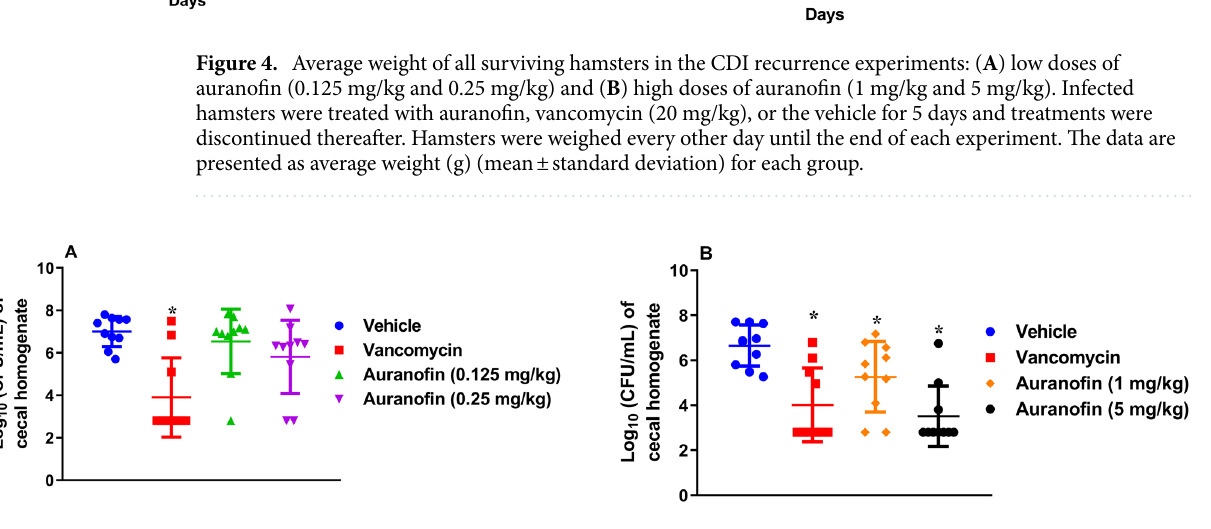
Figure 5. C. difficile UNT103-1 CFU counts in the cecal tissues of infected hamsters: ( A ) low doses of auranofin (0.125 mg/kg and 0.25 mg/kg) and ( B ) high doses of auranofin (1 mg/kg and 5 mg/kg). Infected hamsters were treated with auranofin, vancomycin (20 mg/kg), or the vehicle for 5 days and treatments were discontinued thereafter. Bacteria were recovered from the cecal tissues of hamsters under anaerobic aseptic conditions, serially diluted, and plated. The data were analyzed via a one-way ANOVA with post hoc Dunnett’s test for multiple comparisons ( P < 0.05). An asterisk (*) denotes a statistically significant difference between hamsters treated with either auranofin or vancomycin in comparison to the vehicle-treated